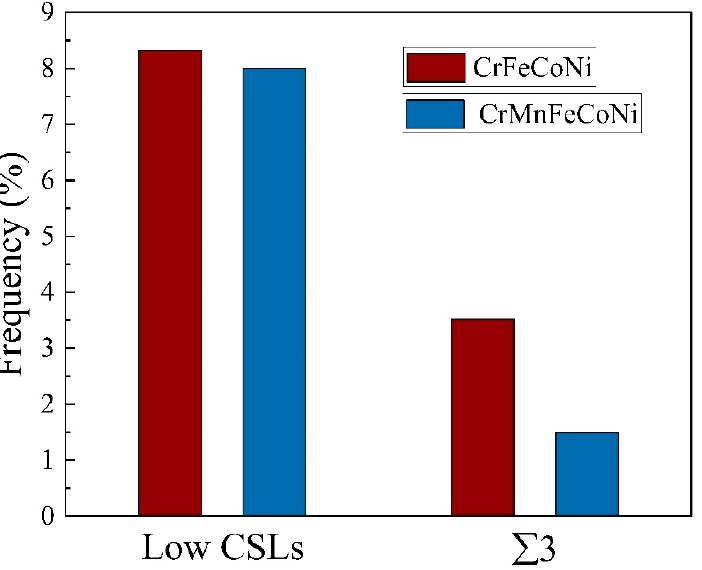
Figure 3. Histogram representing the low CSLs fraction and Σ 3 CSL fraction in the CrFeCoNi and CrMnFeCoNi coatings.